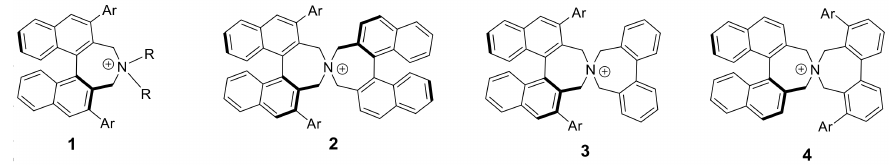
Figure 1. Phase transfer catalysts with dinaphthoazepinium